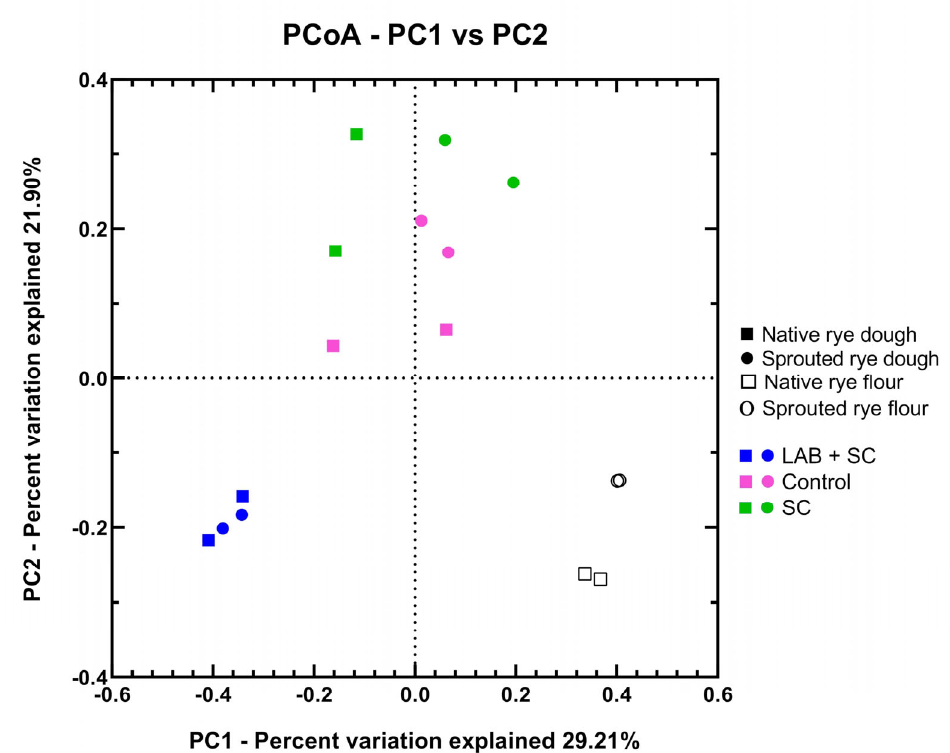
Figure 1. Beta ‐ diversity analysis of rye dough and flour samples. PCoA plot based on unweighted UniFrac distances of microbial communities among all samples. Solid symbols represent doughs made with native rye flour (squares) and sprouted rye flour (circles); empty symbols represent native rye flour (squares) and sprouted rye flour (circles). Dough samples were colored according to the starter used for fermentation: blue = LAB + SC, green = SC, pink = no inoculated starter.